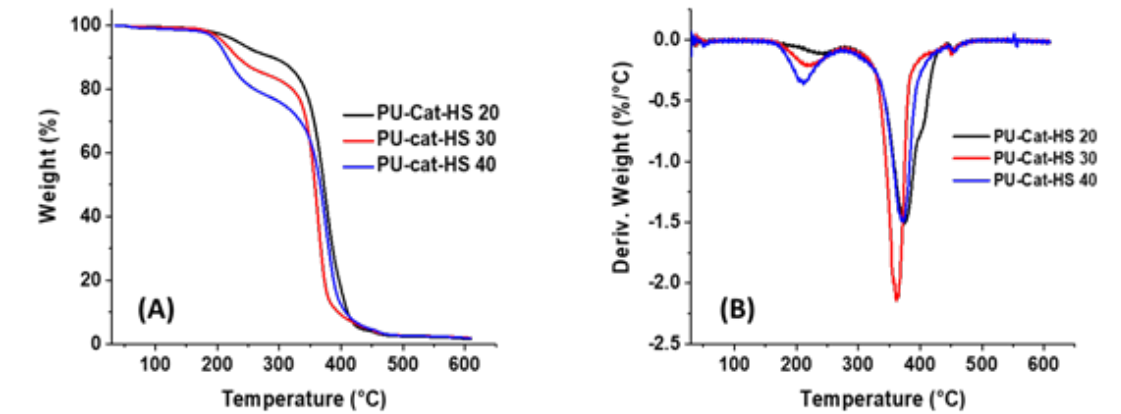
Figure 5. Thermogravimetric analysis of polyurethanes functionalized with catechol in the hard phase. ( A ) The curves of weight loss versus temperature and ( B ) the corresponding derivative.